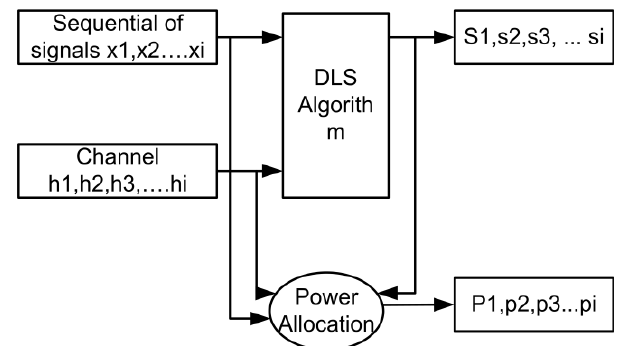
Figure 6. Optimal Power Allocation with the DLS